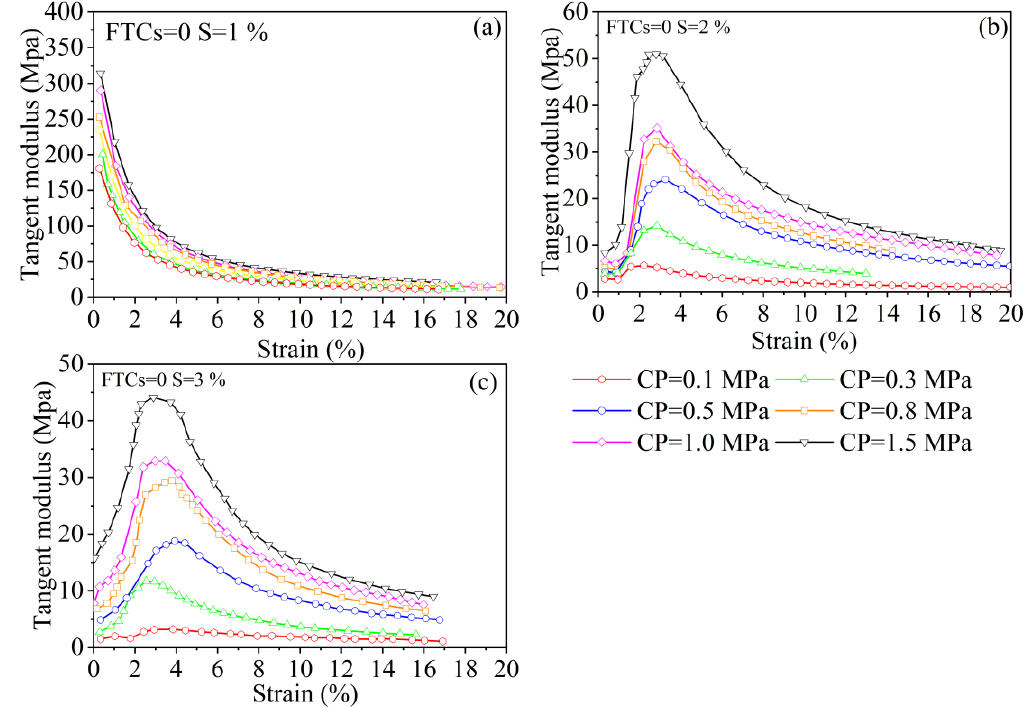
Figure 5. Tangent modulus E s for different salinities at different confining pressures. Notes: FTCs represents freeze–thaw cycles, S represents salinity, and CP represents confining pressure.